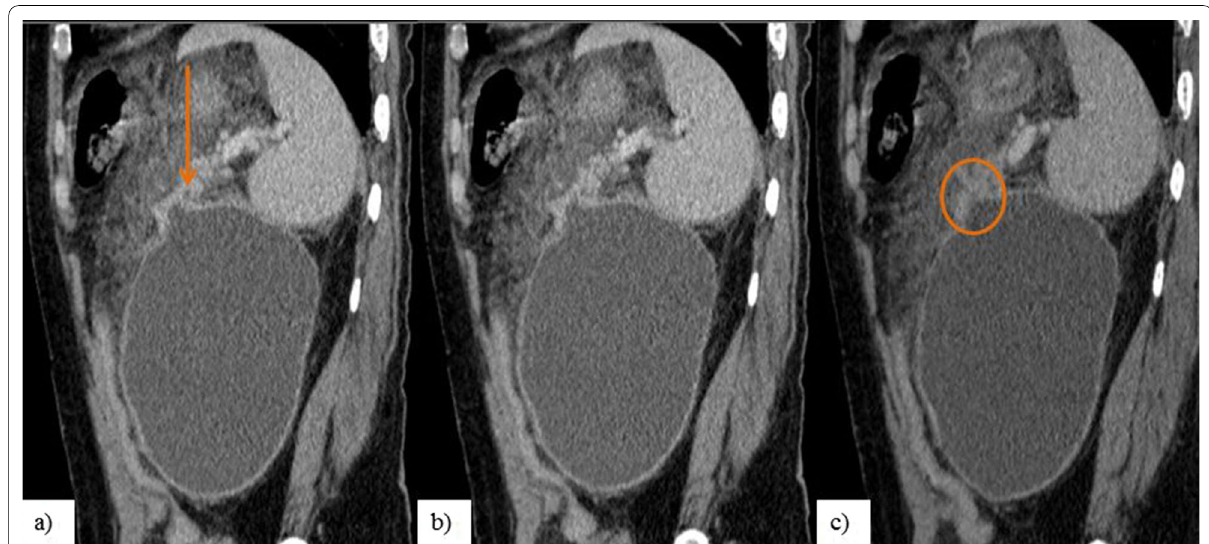
Fig. 2 Sagittal CECT abdomen sequential images show the perirenal pseudocyst communicating with main pancreatic duct in the tail of pancreas resulting in pancreatico-perirenal fistula. Peripancreatic inflammatory changes are also seen. Arrow—main pancreatic duct, circle— pancreatico-perirenal fistula